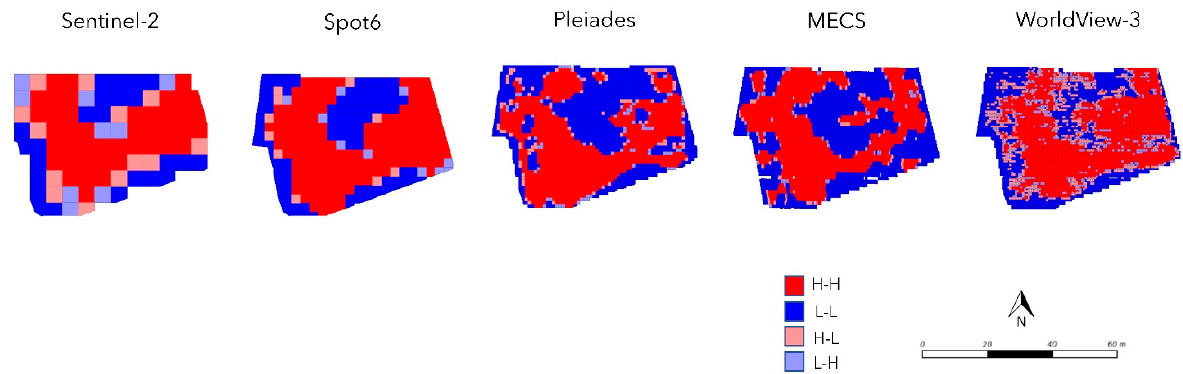
Figure 2. LISA cluster map of Moran univariate Index based on vigor index value (NDVI or CI). The analysis was conducted using a queen contiguity approach with the first-order of neighbors for each acquisition. Different colors correspond to four types of local spatial autocorrelation (red = High-High; dark blue = Low-Low; light red = High-Low; light blue = Low-High).